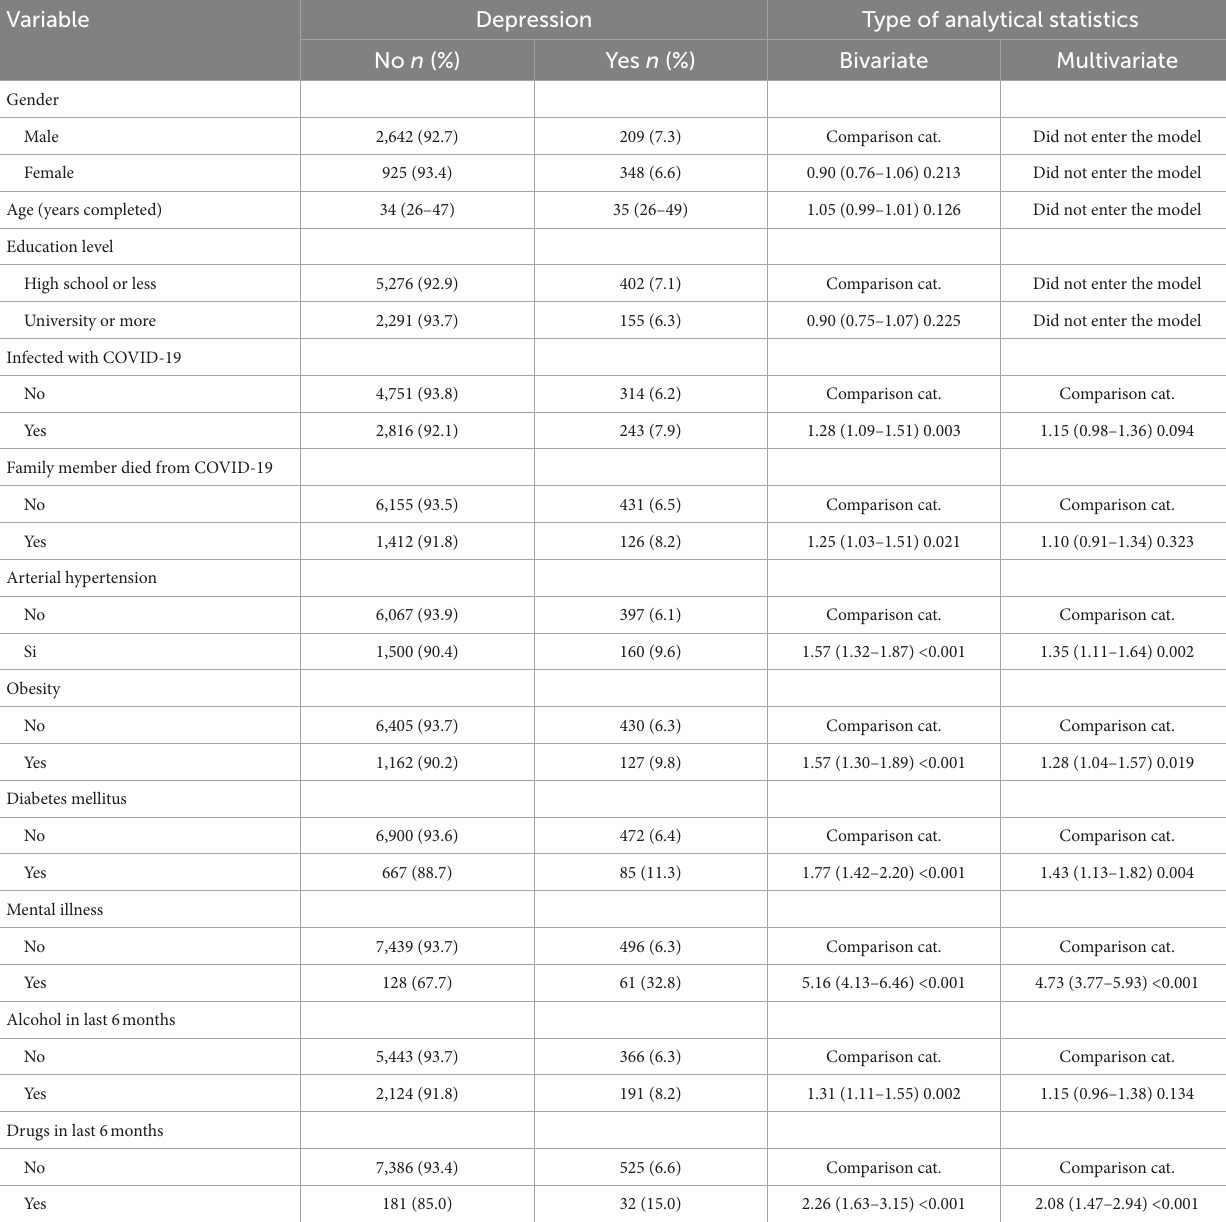
TABLE 3 Factors associated with depression in Honduran residents in the COVID-19 pandemic, in the period 2021–2022, (n =